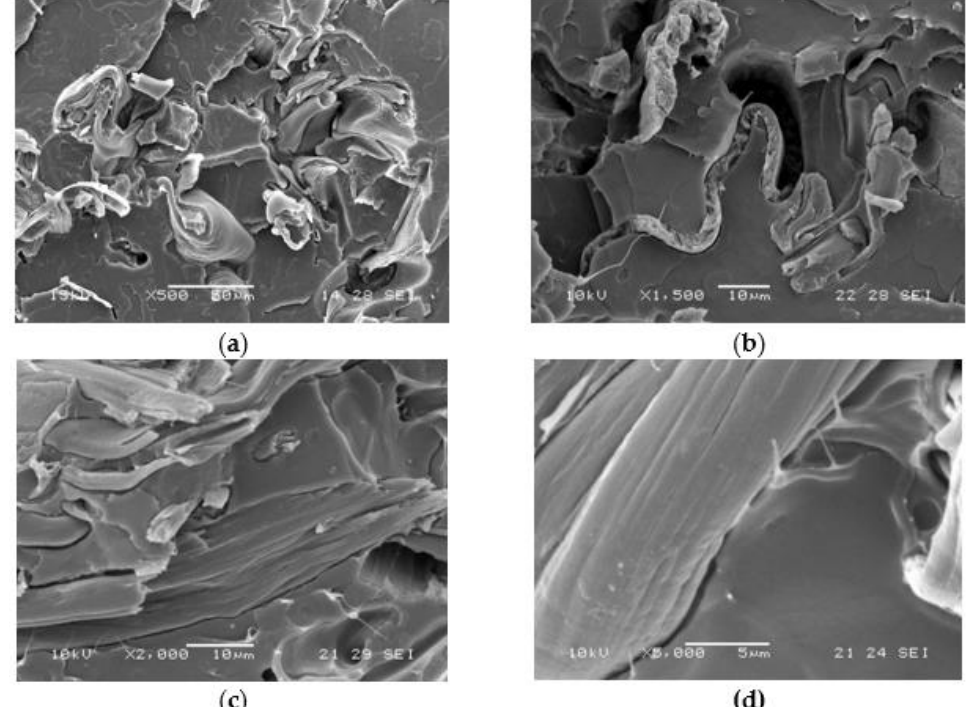
Figure 6. SEM micrographs obtained on cryo-fractured blends: ( a ) PLA85/pAC15 at 500 × magnification; ( b ) PLA85/(pAC+Clab1)15 at 1500 × magnification; ( c ) PLA85/(pAC+C1)15 at 2000 × magnification; ( d ) PLA85/(pAC+C1)15 at 2000 × magnification (detail of the pAC/PLA interface).